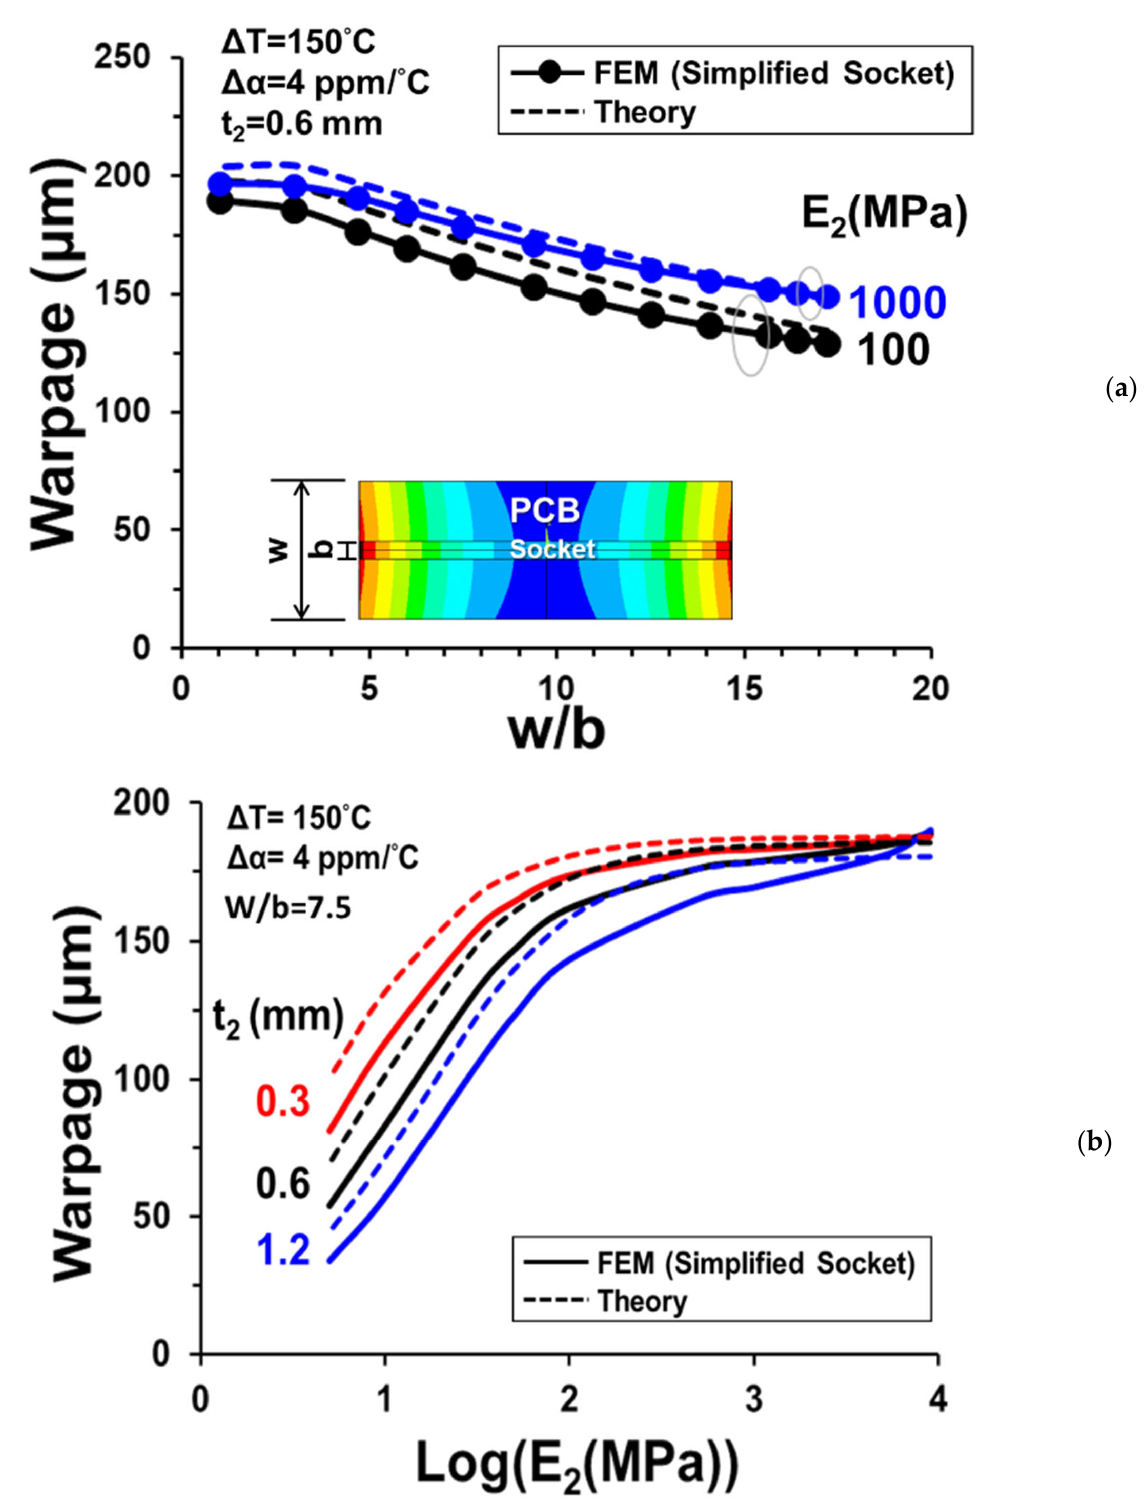
Figure 12. ( a ) Thermally induced warpage (plus an inset of full- fi eld deformation contours) of a one- socket-PCB assembly with various e ff ective moduli of the joint under di ff erent thermal loadings ( Δ T) from FEM with full and simpli fi ed socket models, and ( b ) the out-of-plane deformations (along the line a-a’) of the one-socket-PCB assembly under thermal loading Δ T = 150 °C, from the theory and FEM simulations with full and simpli fi ed socket models.